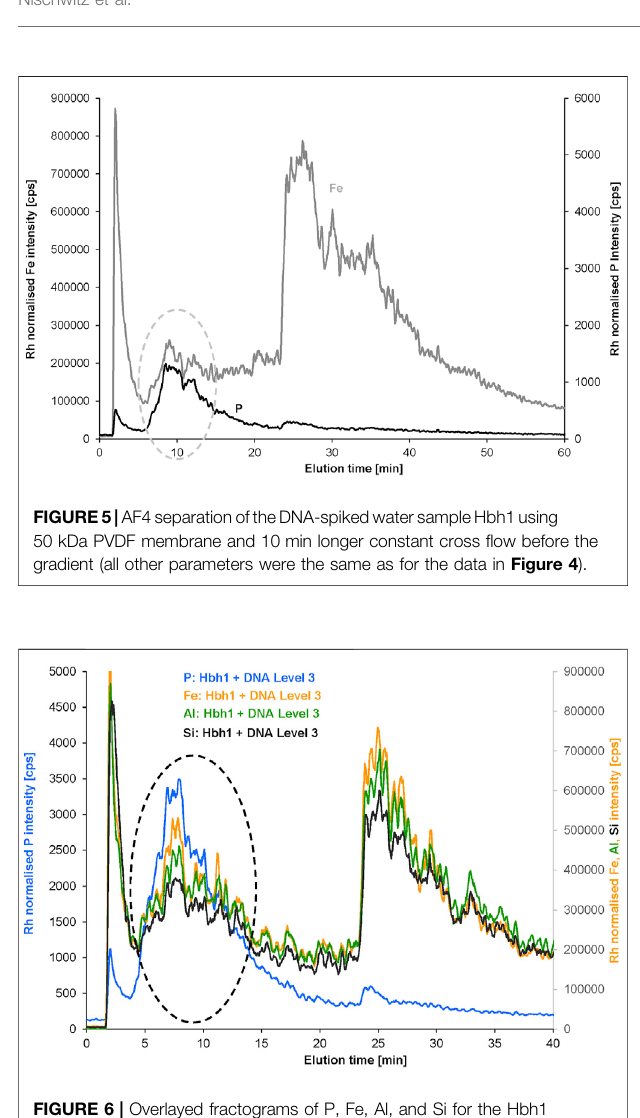
FIGURE 6 | Overlayed fractograms of P, Fe, Al, and Si for the Hbh1 water sample at DNA spike level 3 (the signals of Al and Si were multiplied by scaling factor 9 to match the Fe intensity range).